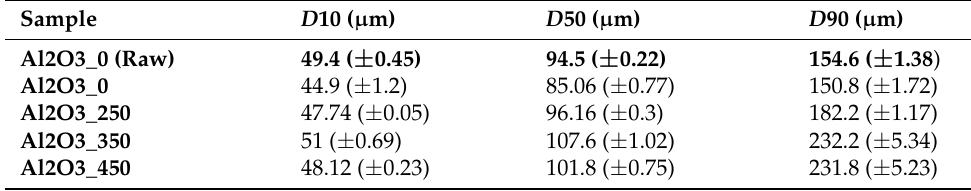
Table 4. PSD of the APTES-modified Al 2 O 3